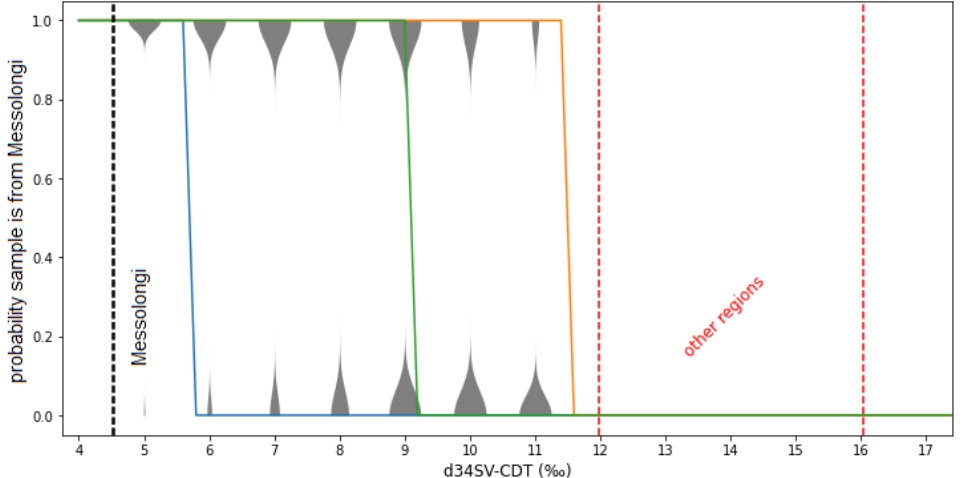
Figure 5. Uncertainty distribution of the proposed characterization